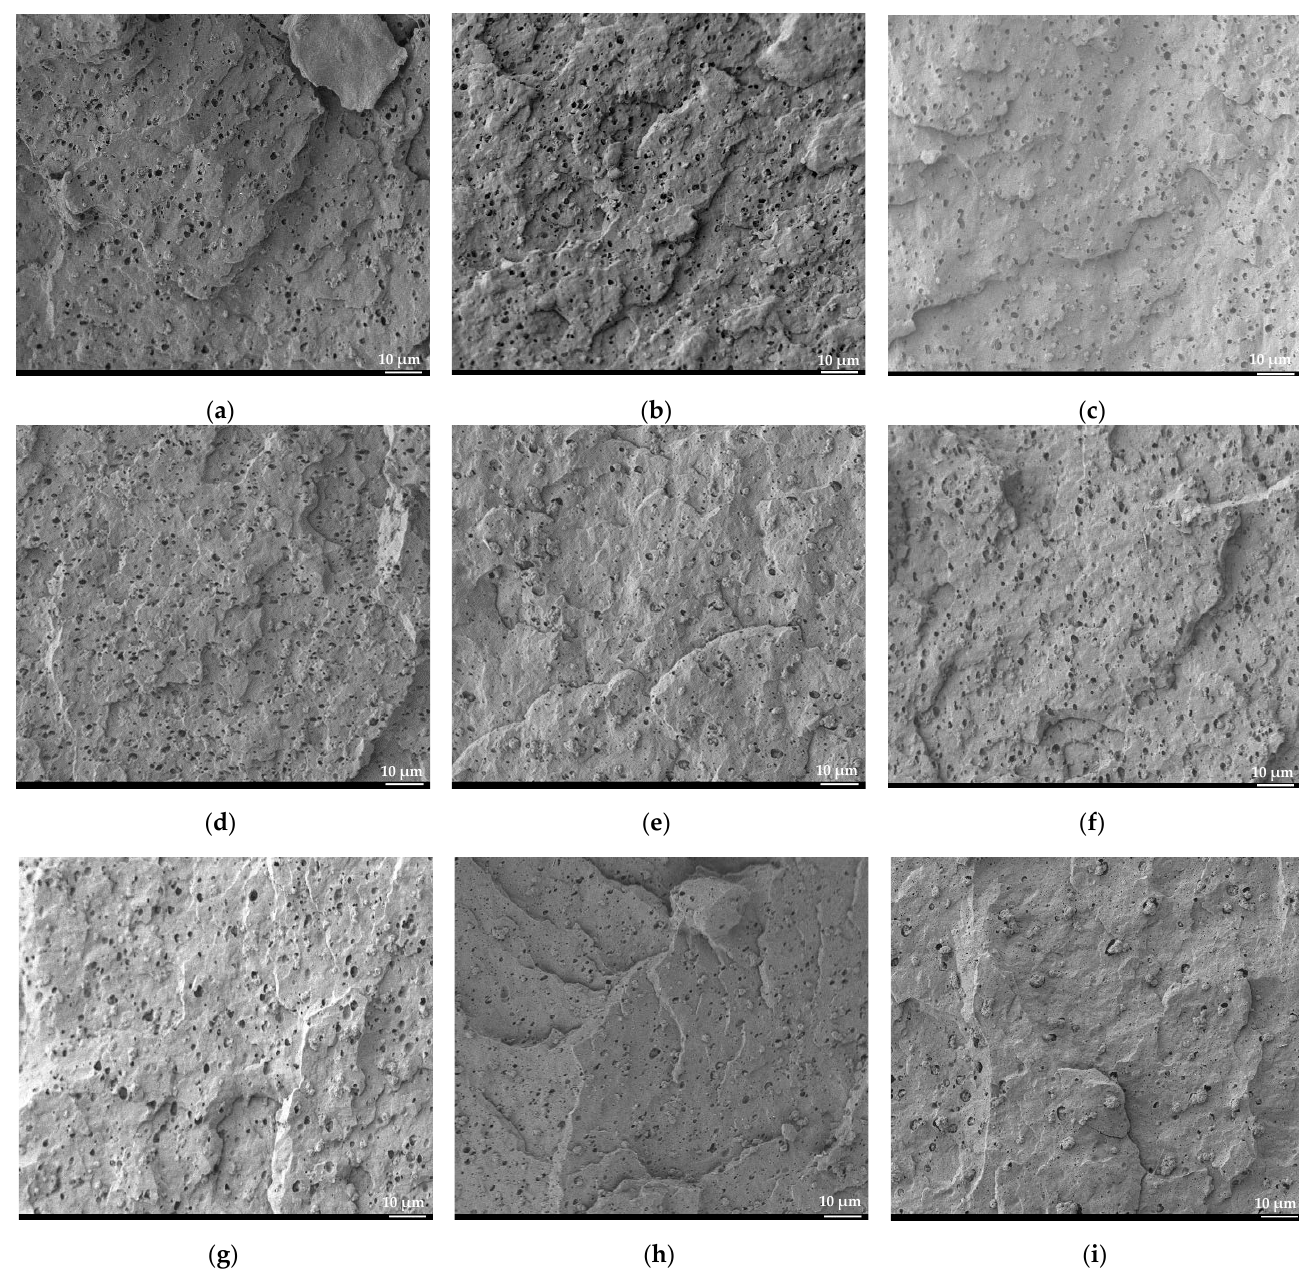
Figure 7. SEM micrographs for ( a ) unprocessed PP; PP reprocessed using a TSE; ( b ) first cycle at 500 rpm; ( c ) third cycle at 500 rpm; ( d ) first cycle at 1500 rpm and ( e ) third cycle at 1500 rpm; and PP reprocessed using a QSE; ( f ) first cycle at 500 rpm; ( g ) third cycle at 500 rpm; ( h ) first cycle at 1500 rpm; and ( i ) third cycle at 1500 rpm.